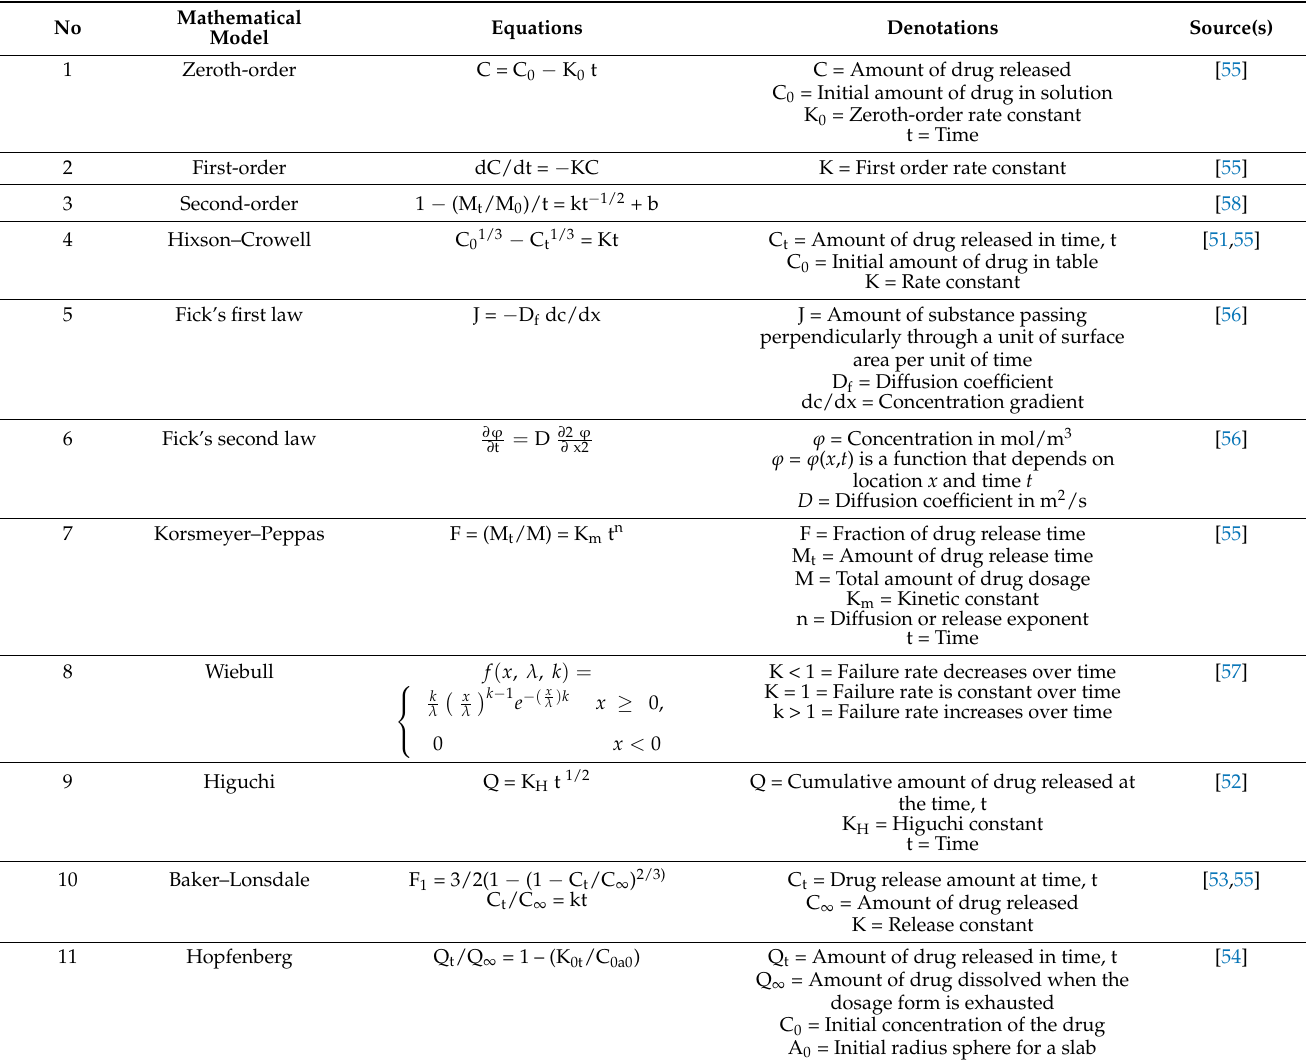
Table 3. A few mathematical models and equations which are often used for controlled-release and kinetic-release characteristics of the AI from the host into the